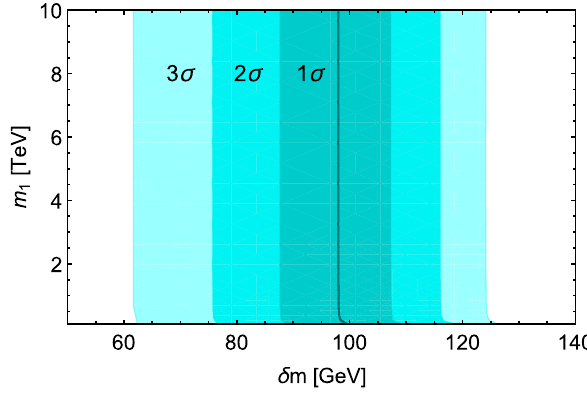
Fig. 4 CDF-allowed regions contoured in δ m – m 1 plane